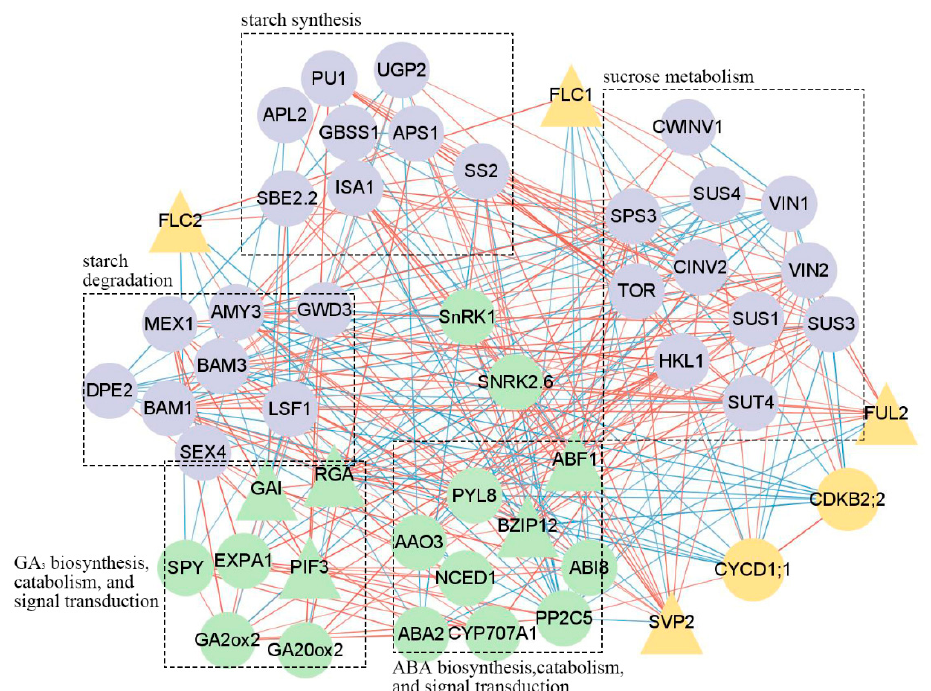
Figure 6. The gene correlation analysis in Iris tectorum during artificial dormancy induction. The correlation was analysed using a Pearson’s two-tailed test. Genes with significant correlations ( p < 0.05) were linked together. The thicker the line is, the correlation coefficient is larger. The red line indicates a positive correlation, and the blue line indicates a negative correlation. Genes with yellow background represent marker genes, genes with green background represent genes involved in the phytohormone biosynthesis, catabolism, and signal transduction, and genes with purple background represent genes involved in the carbohydrate metabolism. Circles represent functional genes, and triangles represent transcription factors. Gene full names are shown in Supplemental Table S1.